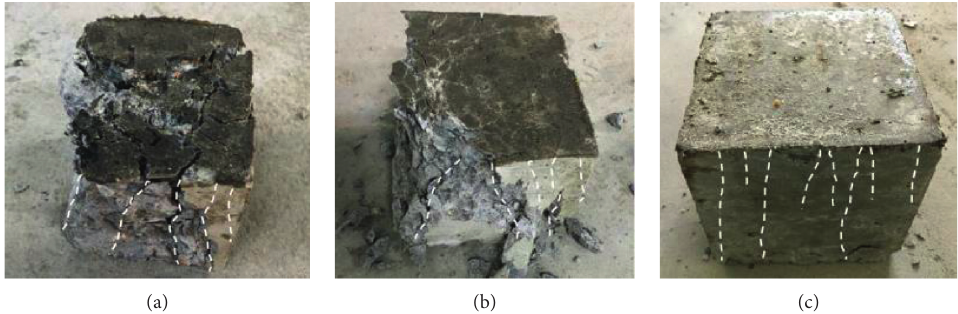
Figure 5: The failure mode under size effect (1.0 × 10 − 5 /s). (a) L � 70 mm. (b) L � 100mm. (c) L � 150mm.